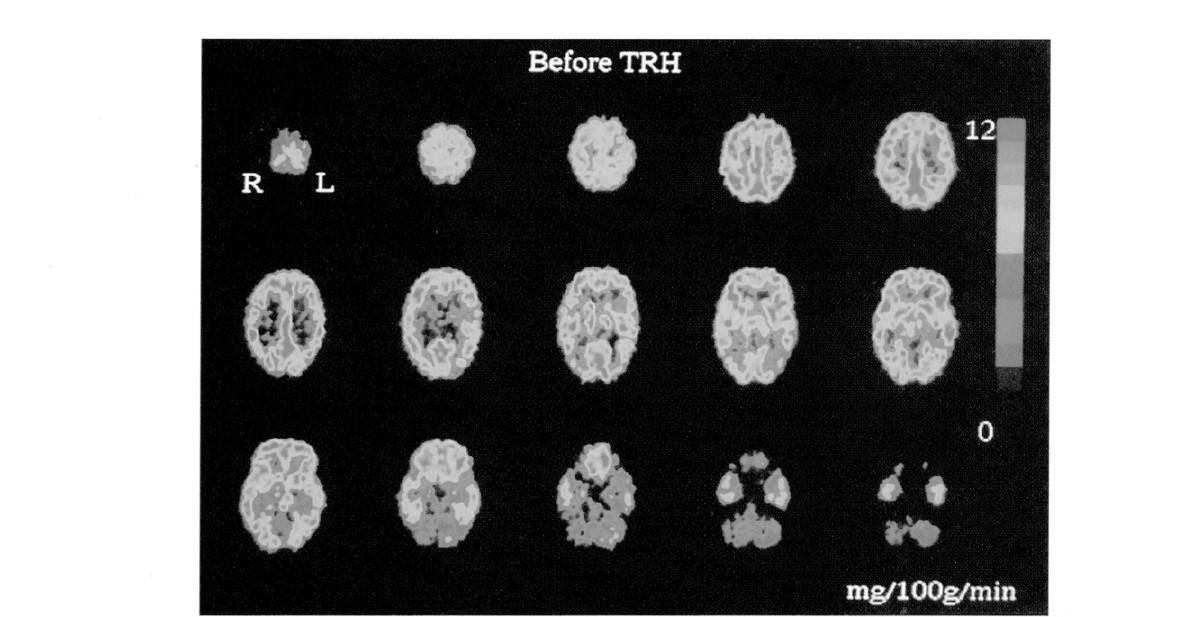
FIG. 2. PET images of the cerebral metabolic rate for glucose (CMRGlc) using ('"FDG) before TRH treatment. CMRGlc was markedly decreased in the cerebellum. In the other regions of the brain, regional CMRGlc was almost normal and there was no difference between right and left hemispheres with focal abnormality.